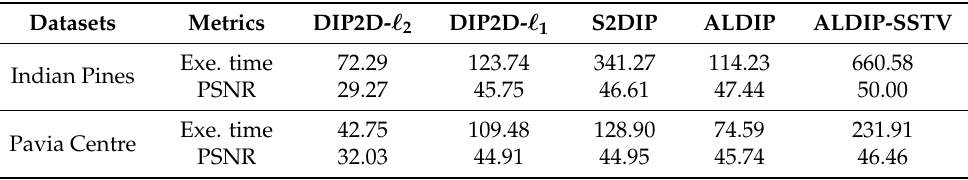
Table 5. The execution time (Exe. time) and PSNR of DIP-based methods on Indian Pines (case 8) and Pavia Centre (case